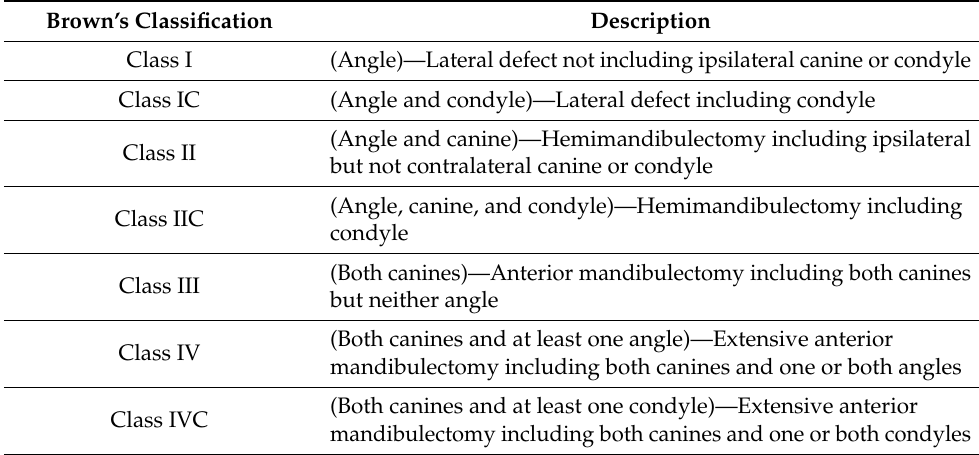
Table 1. Description of Brown’s